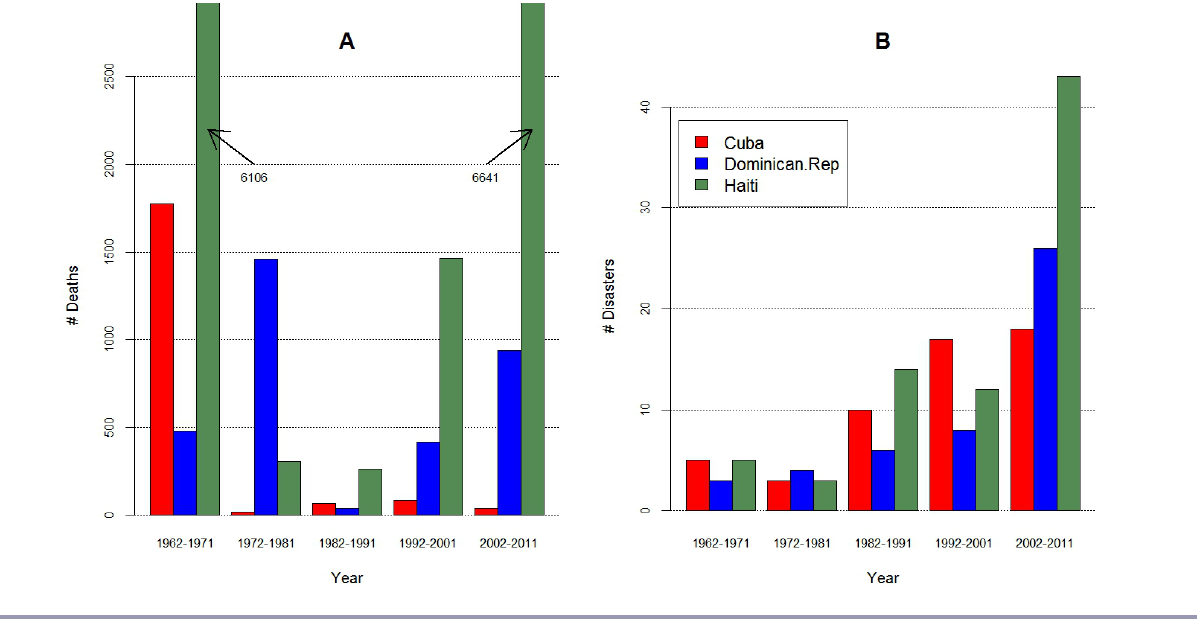
Fig. 1 . Total number of deaths from climatic natural disaster (A) and the number of natural disasters (B) for Cuba, the Dominican Republic, and Haiti between 1962 and 2011, from CRED